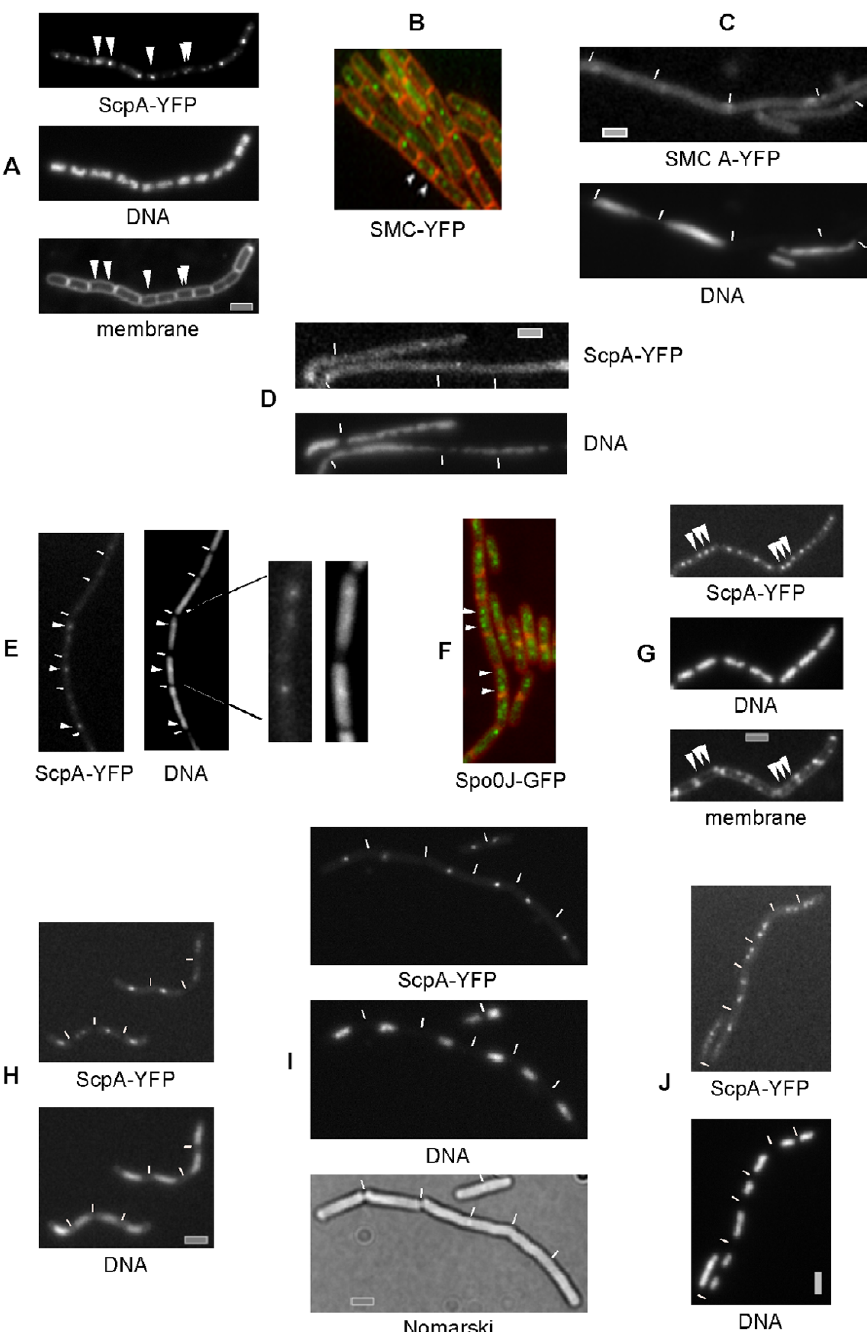
Figure 4 Localization of the SMC complex in live cells depends on several physiological factors. A) Localization of ScpA-YFP in wild-type cells (arrowheads indicate central SMC foci in a newborn cell, two central foci in a slightly older cell, and bipolar foci in a yet older cell), and B) SMC-YFP in wild type cells. C) defective localization of the Walker A motif SMC-YFP mutant protein, D) localization of ScpA-YFP in a strain expressing the C-motif SMC mutant allele only, E) localization of ScpA-YFP, 1 hour after addition of nalidixic acid to block gyrase activity (arrowheads indicate remaining foci). F) localization of Spo0J-GFP, 1 hour after addition of nalidixic acid. G-J) ScpA-YFP in a dnaB ts strain, G) 20–30 min, H) 30–45 min or I) 60 min after shift to 42°C, J) 60 min after shift back from 42°C to 25°C. Arrowheads indicate two bipolar and one central ScpA-YFP foci in (G). White lines indicate septa between cells. Grey bars 2 µ